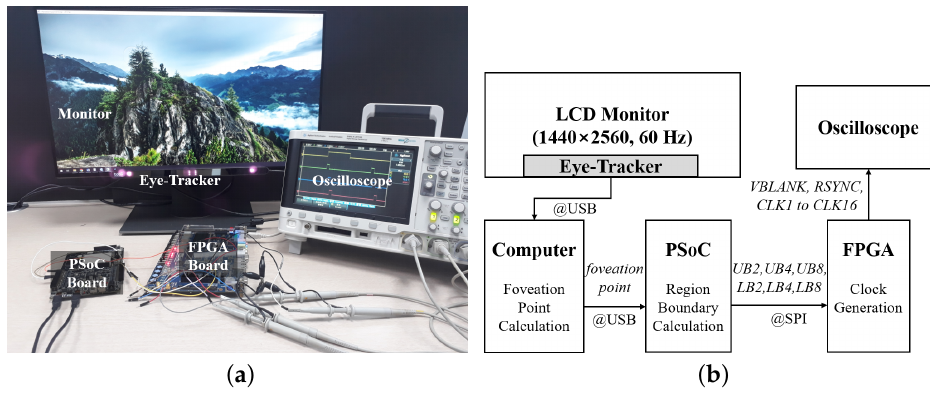
Figure 9. Evaluation environment: ( a ) photograph; and ( b ) block diagram.